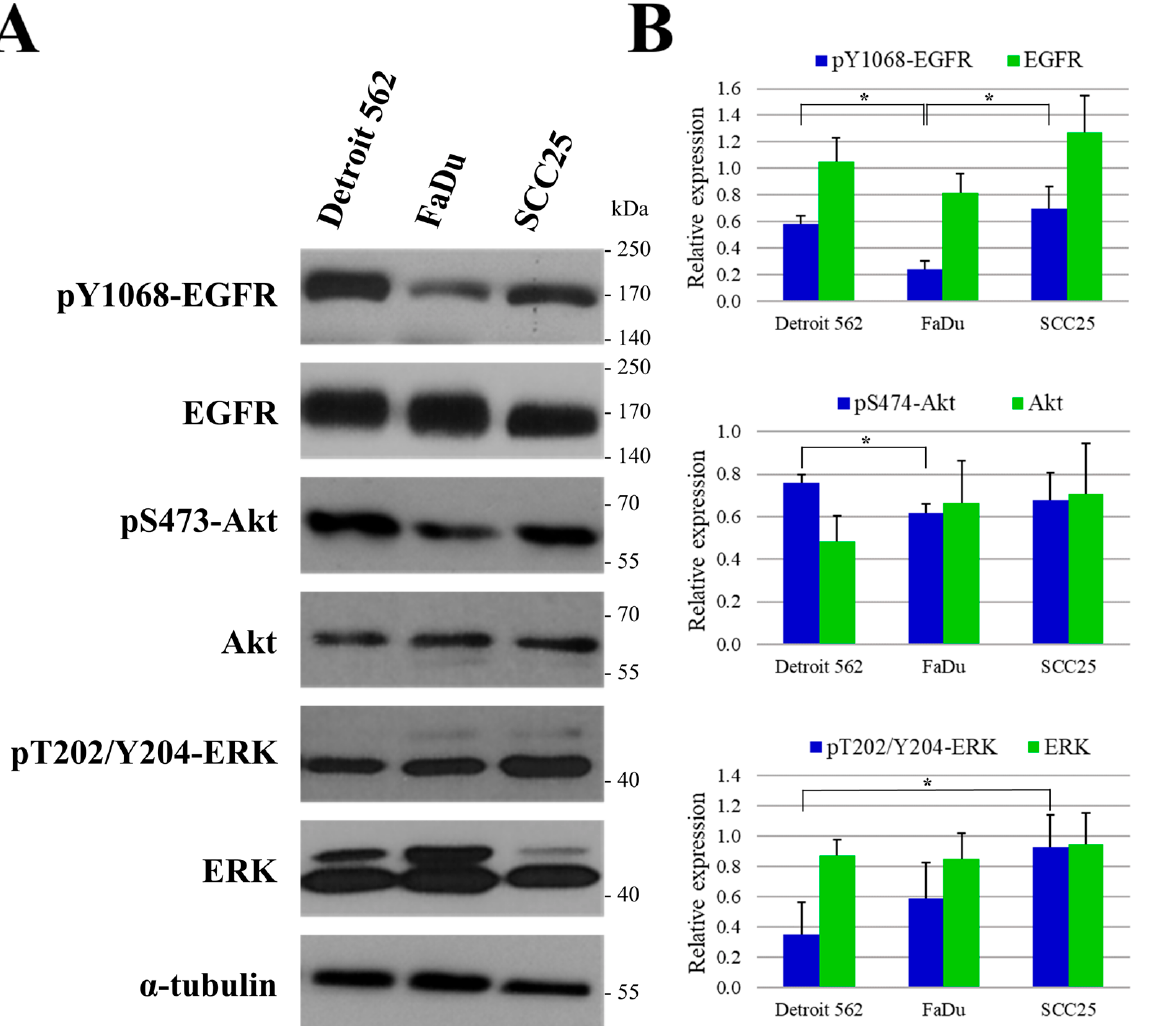
Figure 6. Protein expression and phosphorylation in head-and-neck squamous cell carcinoma (HNSCC) cell lines. ( A ) Cells were subjected to Western blot analysis with antibodies against pY1068-EGFR, EGFR, pS473-Akt, Akt, pT202/Y204-ERK, ERK and the loading control, α -tubulin. ( B ) Densitometry analysis of pY1068-EGFR, EGFR, pS473-Akt, Akt, pT202/Y204-ERK and ERK ex- pression in Detroit 562, FaDu and SCC25 cells. The expressions of all proteins were normalized to expression of α -tubulin. All data are presented as mean ± SD of three independent experiments. The pY1068-EGFR, EGFR, pS473-Akt, Akt, pT202/Y204-ERK and ERK levels of the cell lines were com- pared to each other, and Student’s t -tests were performed for statistically significant differences; * p < 0.05 one cell line vs. another.